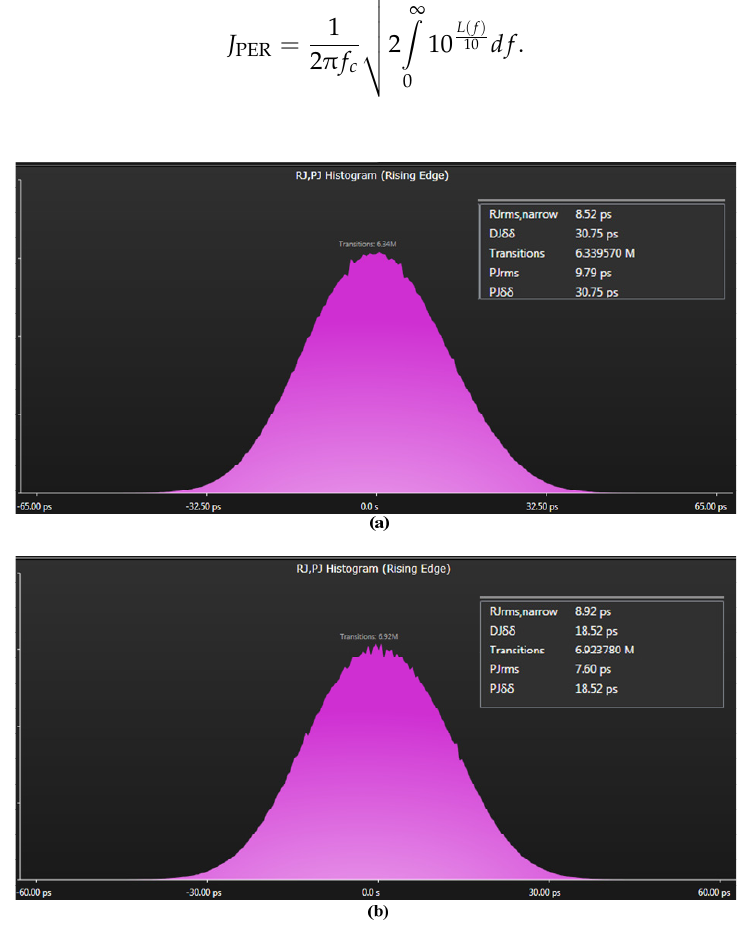
Figure 9. Jitter Histogram of CLKA and CLKB. ( a ) Jitter of CLKA; ( b ) Jitter of CLKB.